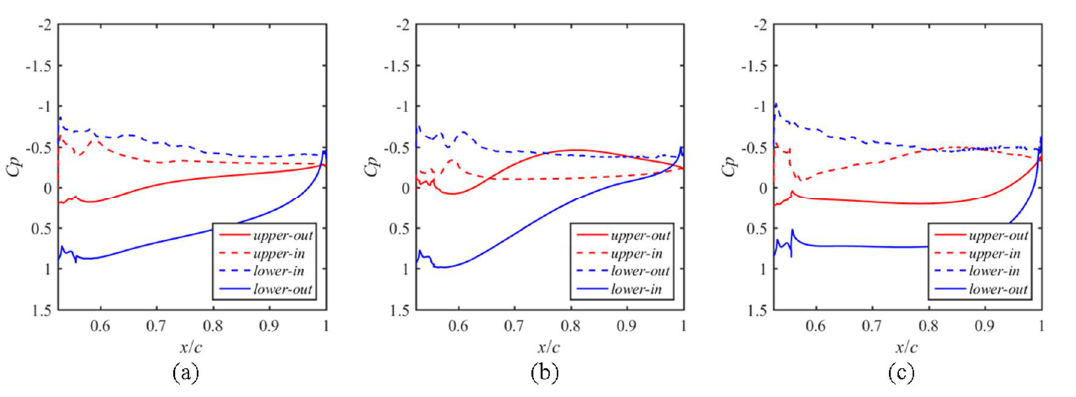
Figure 7. Pressure coefficient of the blade at α = 25°. ( a ) Standard, h = 0.0 mm; ( b ) Positive camber, h = 3.6 mm; ( c ) Negative camber, h = −3.6